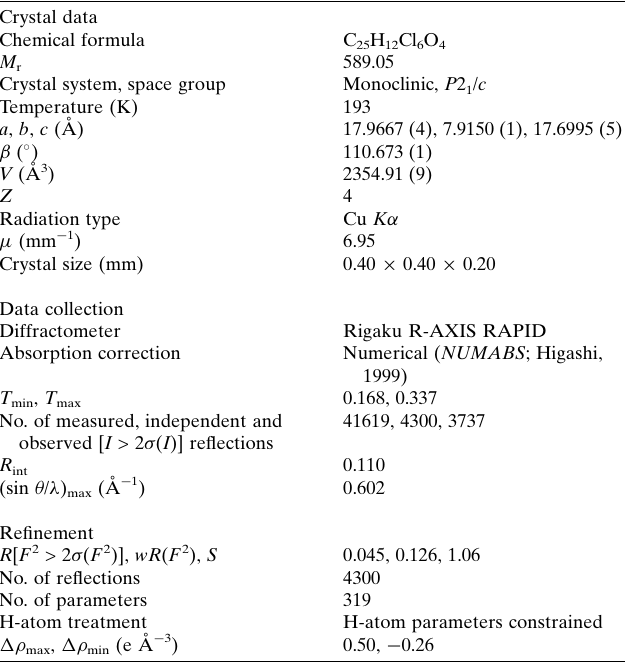
Table 2 Experimental details. Crystal data Chemical